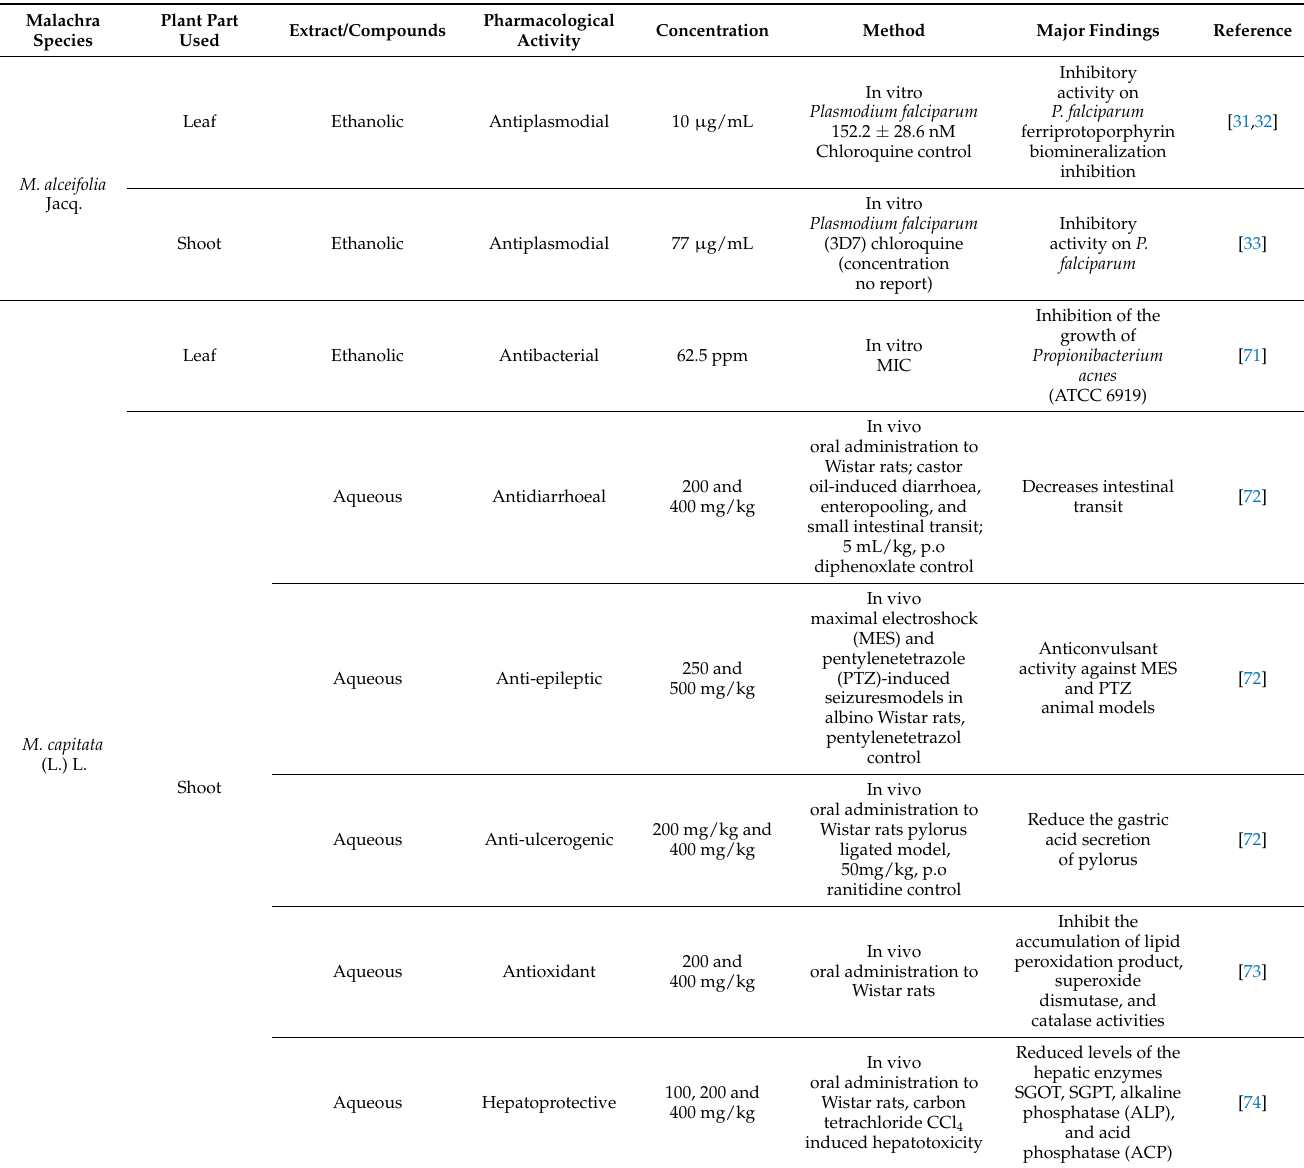
Table 7. Summary of the species of the genus Malachra L. with reported pharmacological